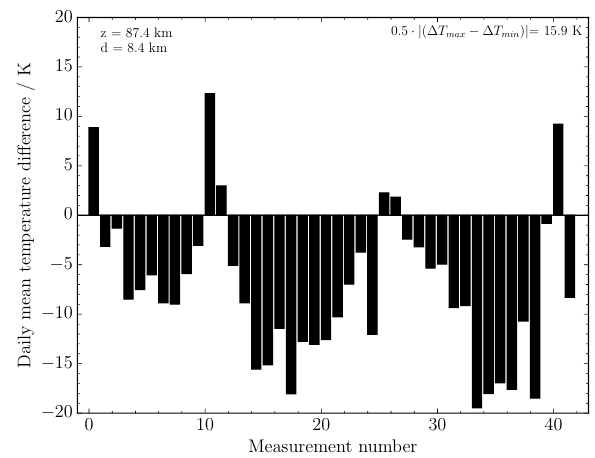
Figure 3. Temperature difference for each day, assuming a fixed a centre altitude of 87.4km and a full width at half maximum of 8.4km for each day. See the Supplement for a list of all measure- ments. misleading and camouflage the ambiguity shown in Fig.